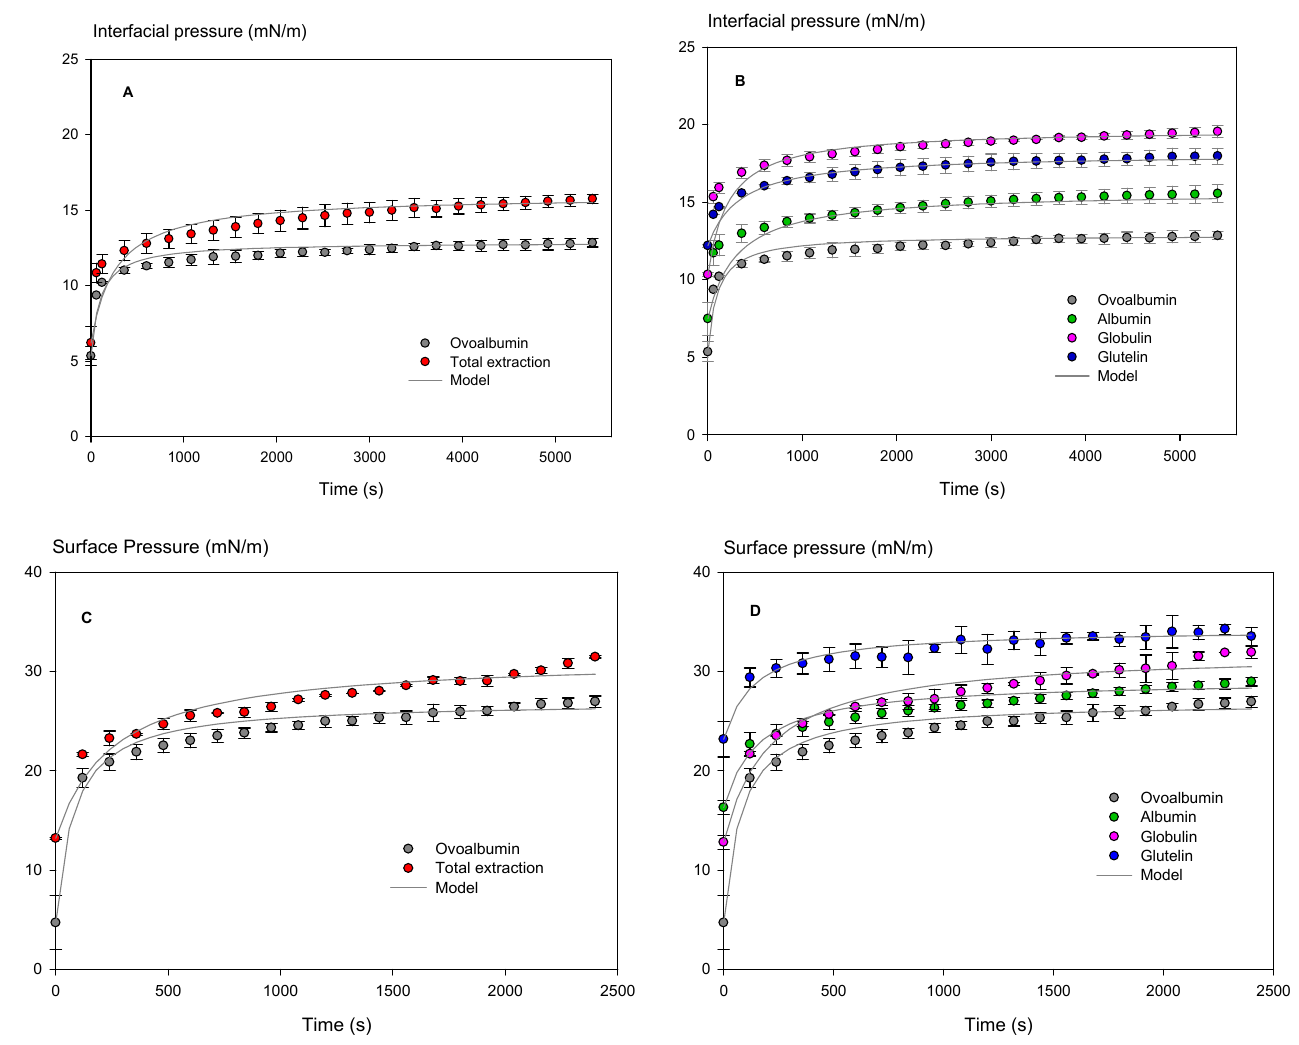
Figure 6. Changes in surface and interfacial pressure between protein dispersions extracted from chickpea flour and commercial ovalbumin. ( A ): Total extraction interfacial pressure concerning ovalbumin; ( B ): Interfacial pressure of albumin, globulin, and glutelin concerning ovalbumin; ( C ): Total extraction surface pressure concerning ovalbumin; ( D ): Surface pressure of albumin, globulin, and glutelin concerning ovalbumin. Protein concentration 0.1% ( w/v ), error bars indicate the mean and standard deviation of triplicates.